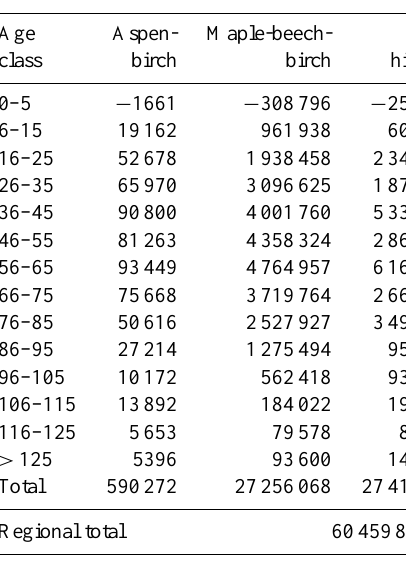
Table 3b. Area-weighted NEP (MgCyr − 1 ) by forest type for the Northeast US (based on the mean values of NEP (MgCha − 1 yr − 1 ) from reforestation